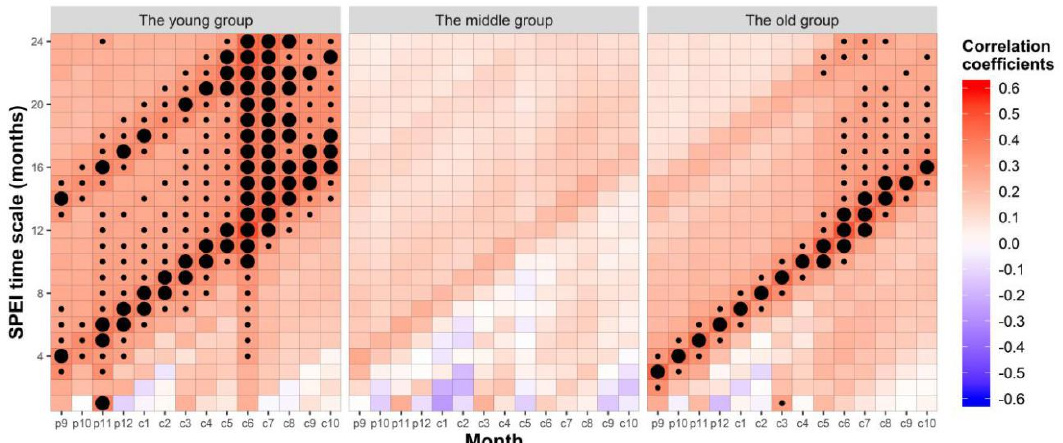
Figure 5. Correlation coefficient between radial growth and standardized precipitation evapotranspiration index ( SPEI ) in the three age groups of Schrenk spruce. The X -axis is the month, and the Y -axis is the duration of the drought. Red: positive correlation; blue: negative correlation; big black point: significance level <0.01; small black point: significance level <0.05; P: previous year; C: current year (for example, P9: September of the previous year, C1: January of the year, a big black spot with X = C9 and Y = 4 indicates that the standard chronology of the young trees has a significant positive correlation with the SPEI lasting for four months in the previous September).